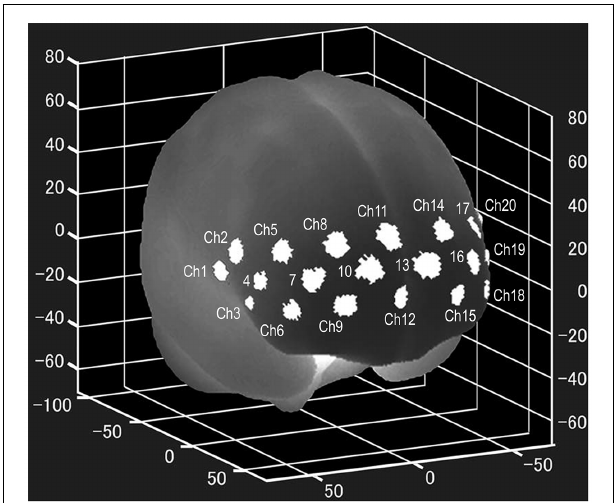
FIGURE 1 | Locations of the NIRS channels. The mean estimated locations of the studied channels of the wearable 16 Ch-NIRS WOT-100 system (HITACHI, Tokyo, Japan), represented in the MNI standard brain space, using the probabilistic estimation method for 10 volunteers (Atsumori et al., 2010). Ch 20, 21, and 22 are on the left side of the brain and are difficult to see in the figure. Ch 1, 2, 3, 20, 21, and 22 are optional channels, which our institution does not have access to. NIRS, near-infrared spectroscopy; MNI, Montreal Neurological